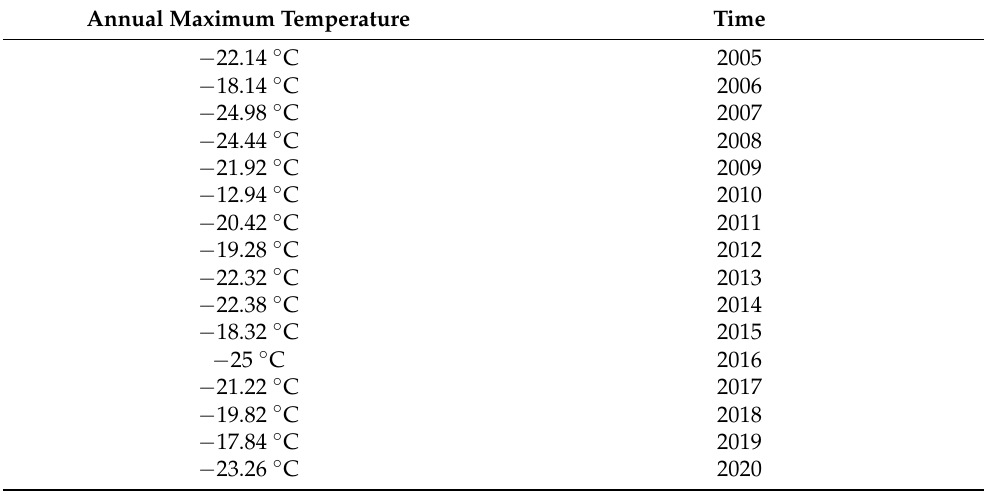
Table 6. Maximum air temperatures from automatic weather stations.